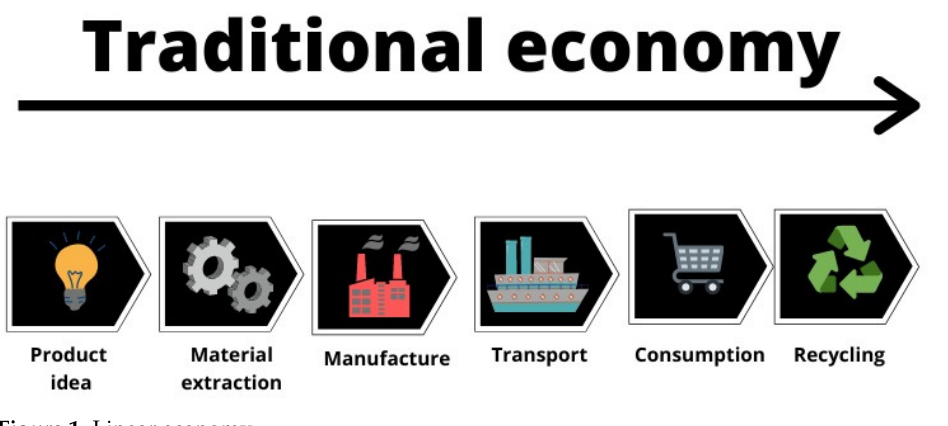
Figure 1. Linear economy.